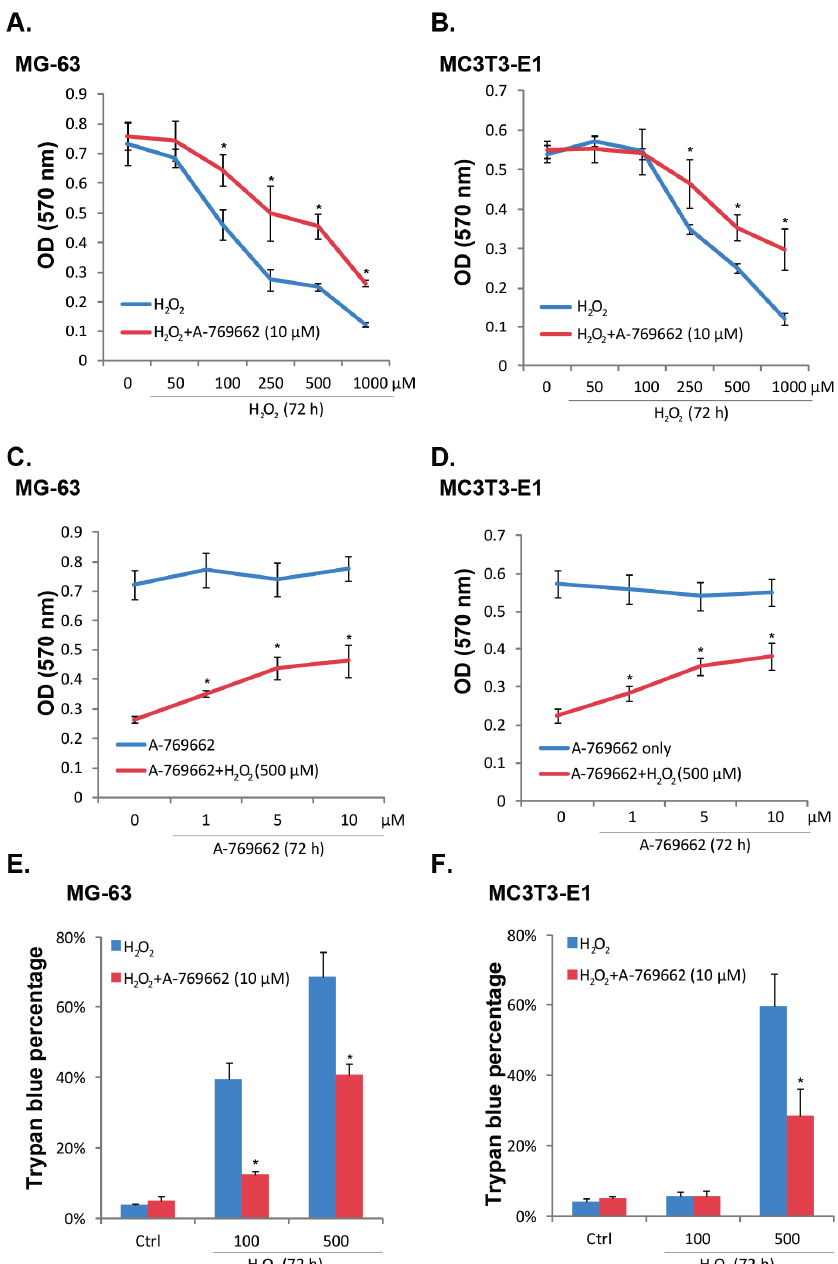
Figure 1. A-769662 inhibits H O -induced osteoblast cell death. Cultured human and 2 2 mouse osteoblast-like cell lines (MG-63 and MC3T3-E1) were pre-treated with A-769662 (10 μ M) for 1 h, followed by hydrogen peroxide (H O , 50–1000 μ M) stimulation, cells 2 2 were further cultured for 72 h, and MTT assay was performed to test cell viability ( A ) and ( B ); trypan blue staining was utilized to test cell death ( E ) and ( F ); MG-63 and MC3T3-E1 cells were pre-treated with different concentration of A-769662 (1, 5 and 10 μ M) for 1 h, followed by H O (500 μ M) stimulation, cells were further cultured for 72 h, and 2 2 3-[4,5-dimethylthiazol-2-yl]-2,5-diphenyltetrazolium bromide (MTT) assay was performed to test cell viability ( C ) and ( D ). Values in this figure were expressed as mean ± SD, experiments were repeated 3 times and similar results were obtained (same for all figures). * p < 0.05 vs. group without